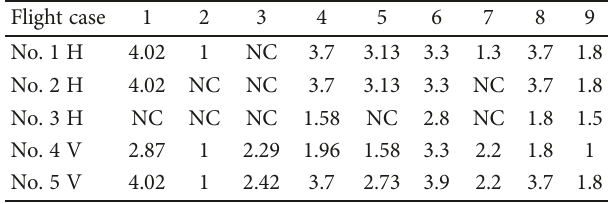
Table 9: Decision results in the far